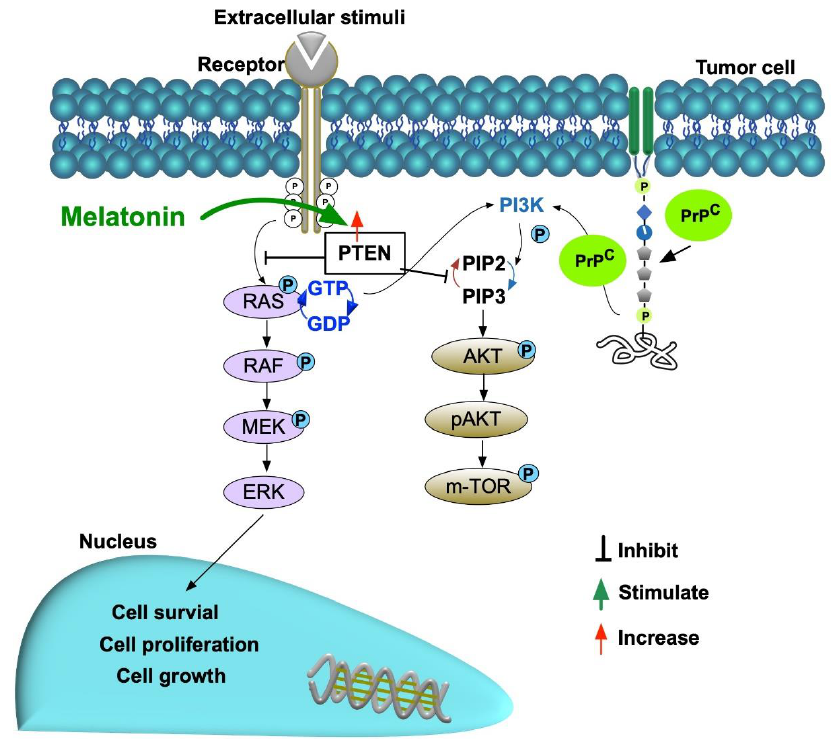
Figure 14. Schematically proposed mechanism of cell stress/cell proliferation signaling pathways (i.e., RAS and PI3K) involving in regulating the bladder cancer cell growth, differentiation, proliferation, and invasion and Melatonin upregulated the PTEN for suppressing RAS and PI3K signaling pathways. PrP C = cellular prion protein.